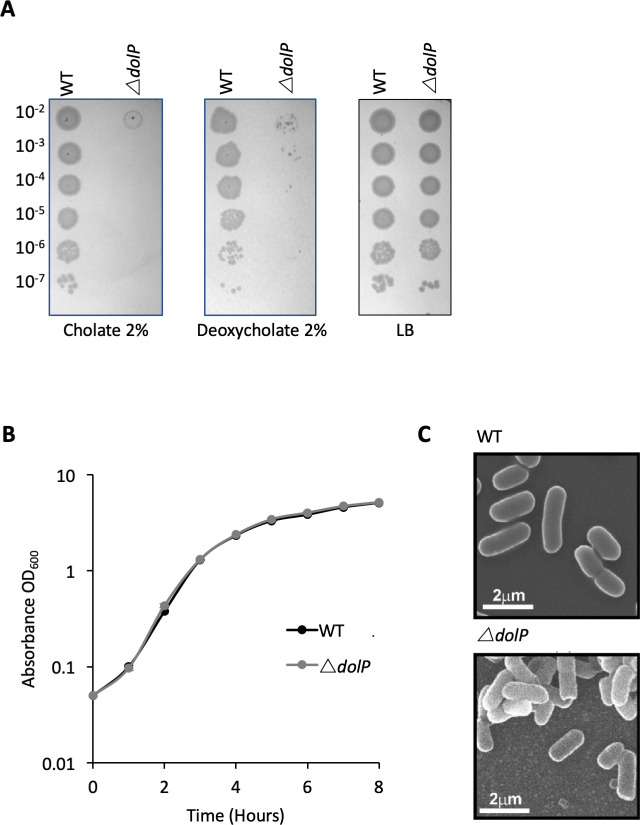
Phenotypes of E. coli BW25113 ∆dolP.(A) Mutants lacking dolP are sensitive to the anionic detergents cholate and deoxycholate (B) Mutants lacking dolP have growth rates that are indistinguishable from wild-type E. coli. (C) Scanning electron microscopy reveals parental and E. coli ∆dolP cells have no discernible differences in cellular morphology.Figure 1—figure supplement 4—source data 1.Comparison of bacterial growth rates of wild type and yraP mutant.